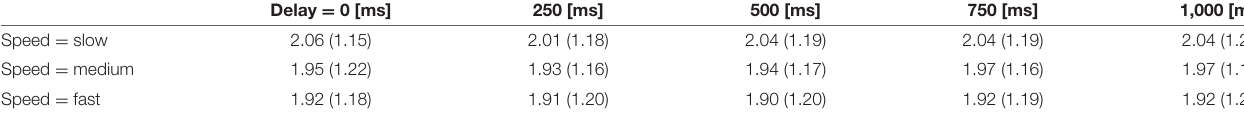
TABLE 8 | Average (standard deviation) of background-luminance rating scores.